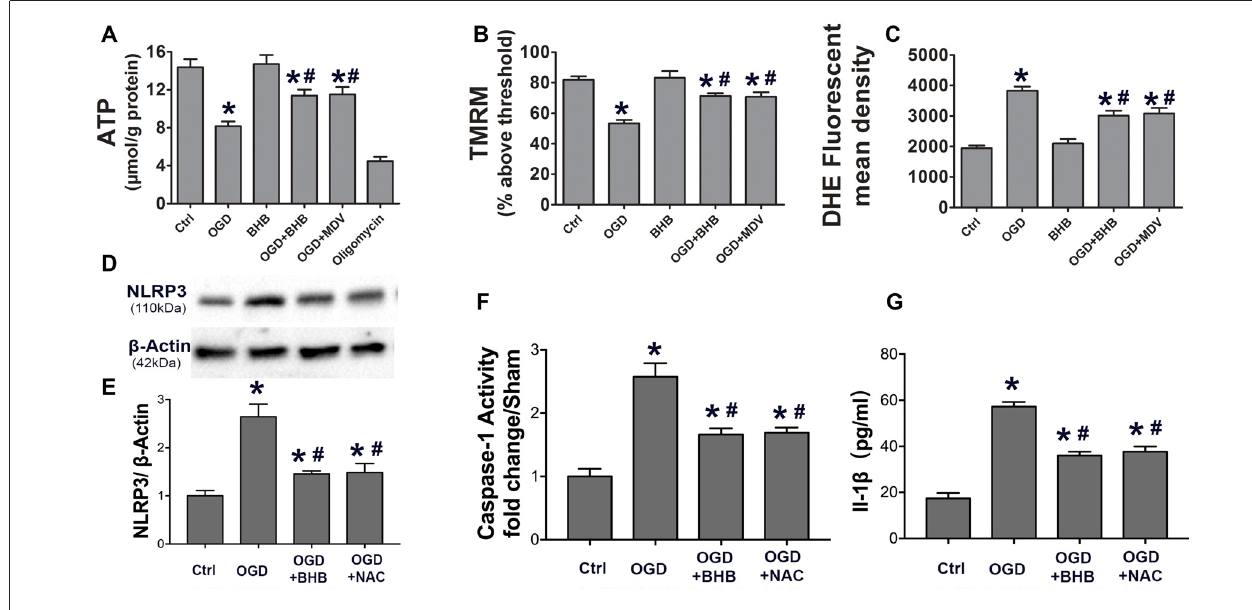
FIGURE 6 | BHB and mdivi-1 prevented mitochondrial function and reactive oxygen species (ROS) inhibitor N-acetyl-L-cysteine (NAC) suppressed NLRP3 inflammasome after OGD/R. (A) BHB and mdivi-1 reversed the decreased ATP production after OGD/R. Oligomycin (oligo, 10 µ M, a complex V inhibitor), as a positive control, significantly reduced ATP level. Data were normalized to those from oligomycin-treated cells. BHB and mdivi-1 reversed the increase in ROS production (C) and the decrease in mitochondrial membrane potential (MMP) (B) after OGD/R. (D,E) The ROS inhibitor NAC was added before OGD, and the protein expression of NLRP3 was detected by Western blotting. Representative blots from six independent experiments with similar results are shown. (F) Caspase-1 activity was detected on cell lysates and compared to that in sham-operated mice. (G) IL-1 β production in culture media. Data are shown as mean ± SEM; ∗ P < 0.01 vs. Ctrl group, # P < 0.05 vs. OGD group.